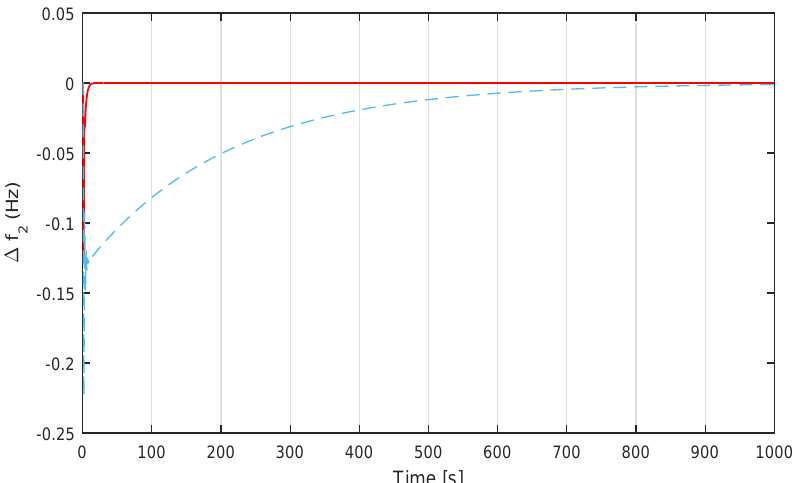
Figure 13. The Compared responding curves ∆ f 2 of V2G system subjected to SOC(solid: proposed, dashed: [10]).